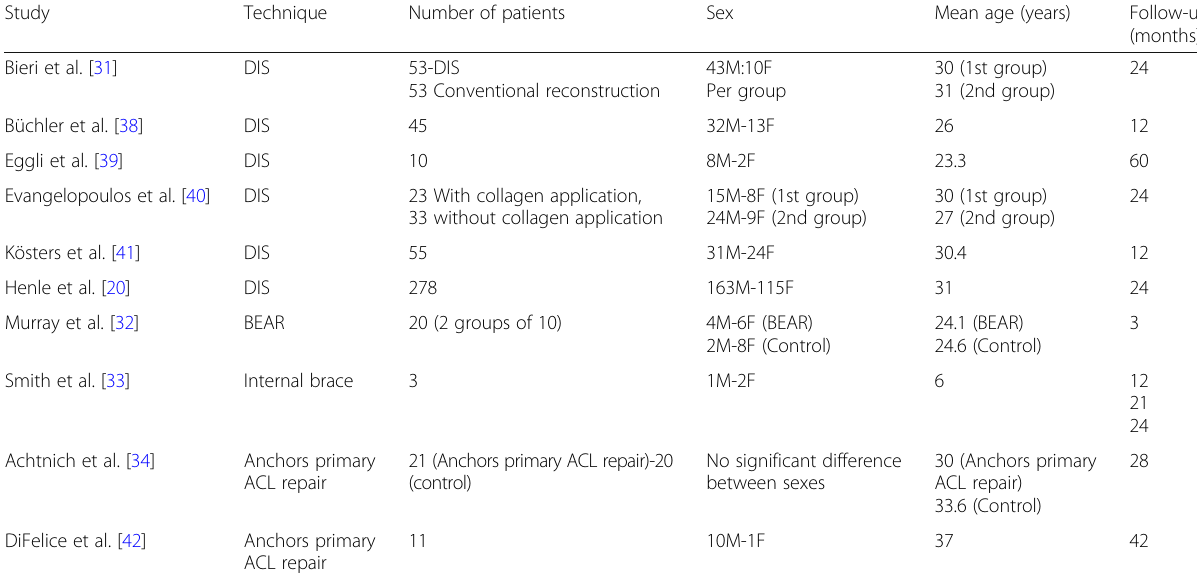
Table 2 Demographic data and mean follow-up per clinical study Study